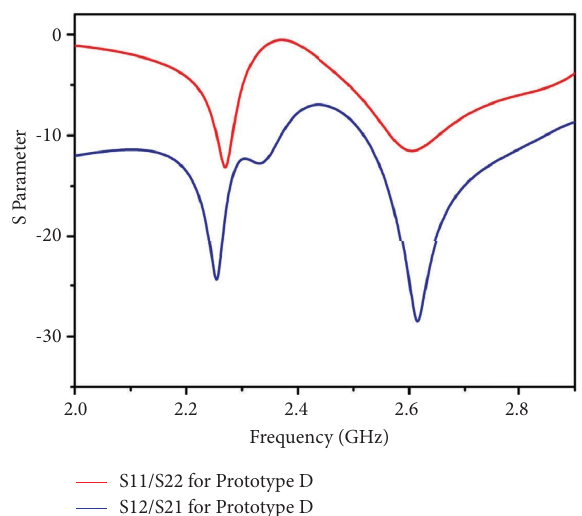
Figure 8: S -parameters versus frequency for dual-frequency decoupling